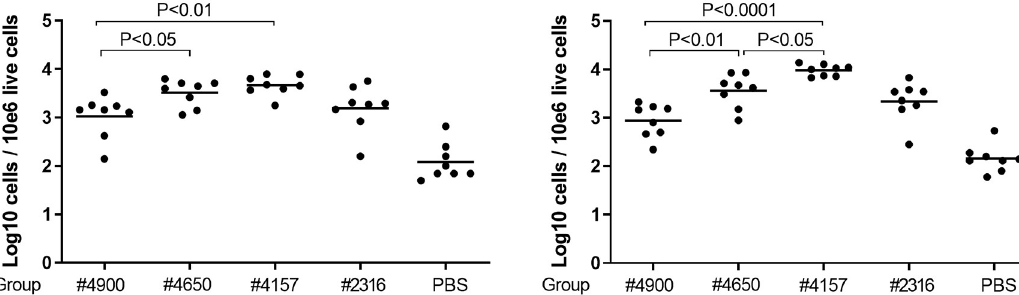
Fig 5. Protective immunization regimens induce lower HA-specific B cells responses post-boost immunizations. Frequencies of HA-binding cells among GC B cell (A) and non-GC B cell (B) populations in iliac lymph nodes as measured at day 25 (4 days post- boost immunization) in mice (n = 8 per time-point per cohort) vaccinated with the alum-adjuvanted Mini-HA UFV#4900, UFV#4650, UFV#4157 antigens (30 μ g), FL HA FL H1#2316, at an equimolar dose of 60 μ g, or PBS. Each symbol represents one animal while group means are indicated by a horizontal bar. Statistical comparisons are made by comparing group means of the miniHA vaccinated animals in a one-way ANOVA, corrected for multiple comparisons using Tukey’s statistical hypothesis testing.